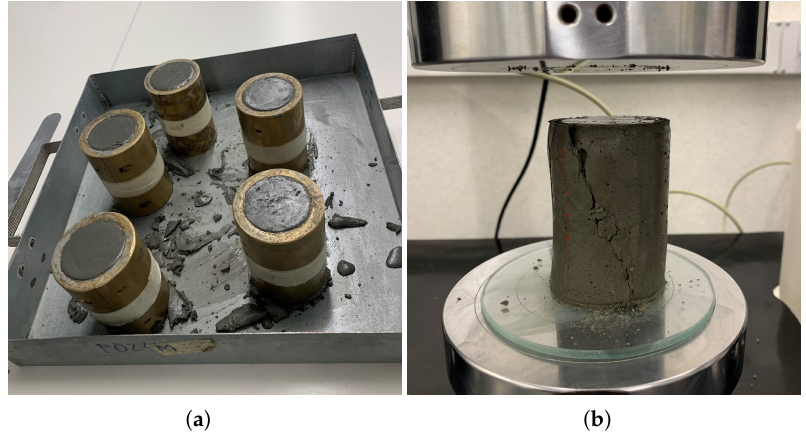
Figure 4. ( a ) Molds for UUCT, and ( b ) Fresh specimen after the green strength test at 120